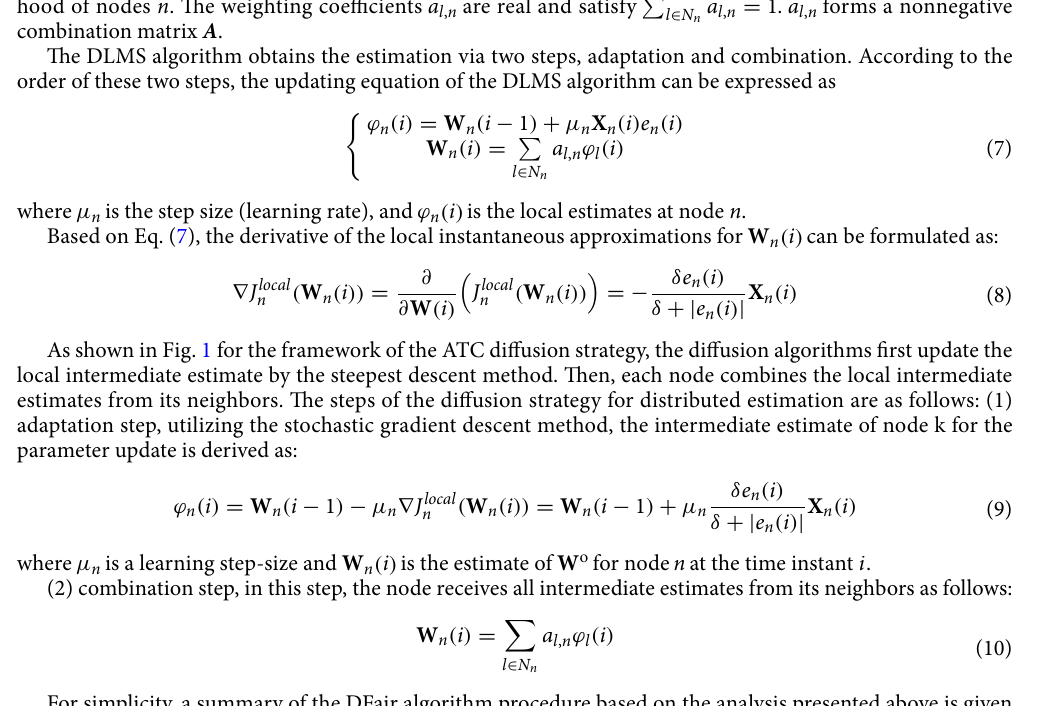
1 ) is the unknown system parameter vector with length M , and v n ( i ) is the measurement inter- where W o ( M × ference with variance σ 2 v , n and each node has a different value of v n ( i ) . In 9 , the DLMS algorithm is obtained by minimizing a linear combination of the local MSE: